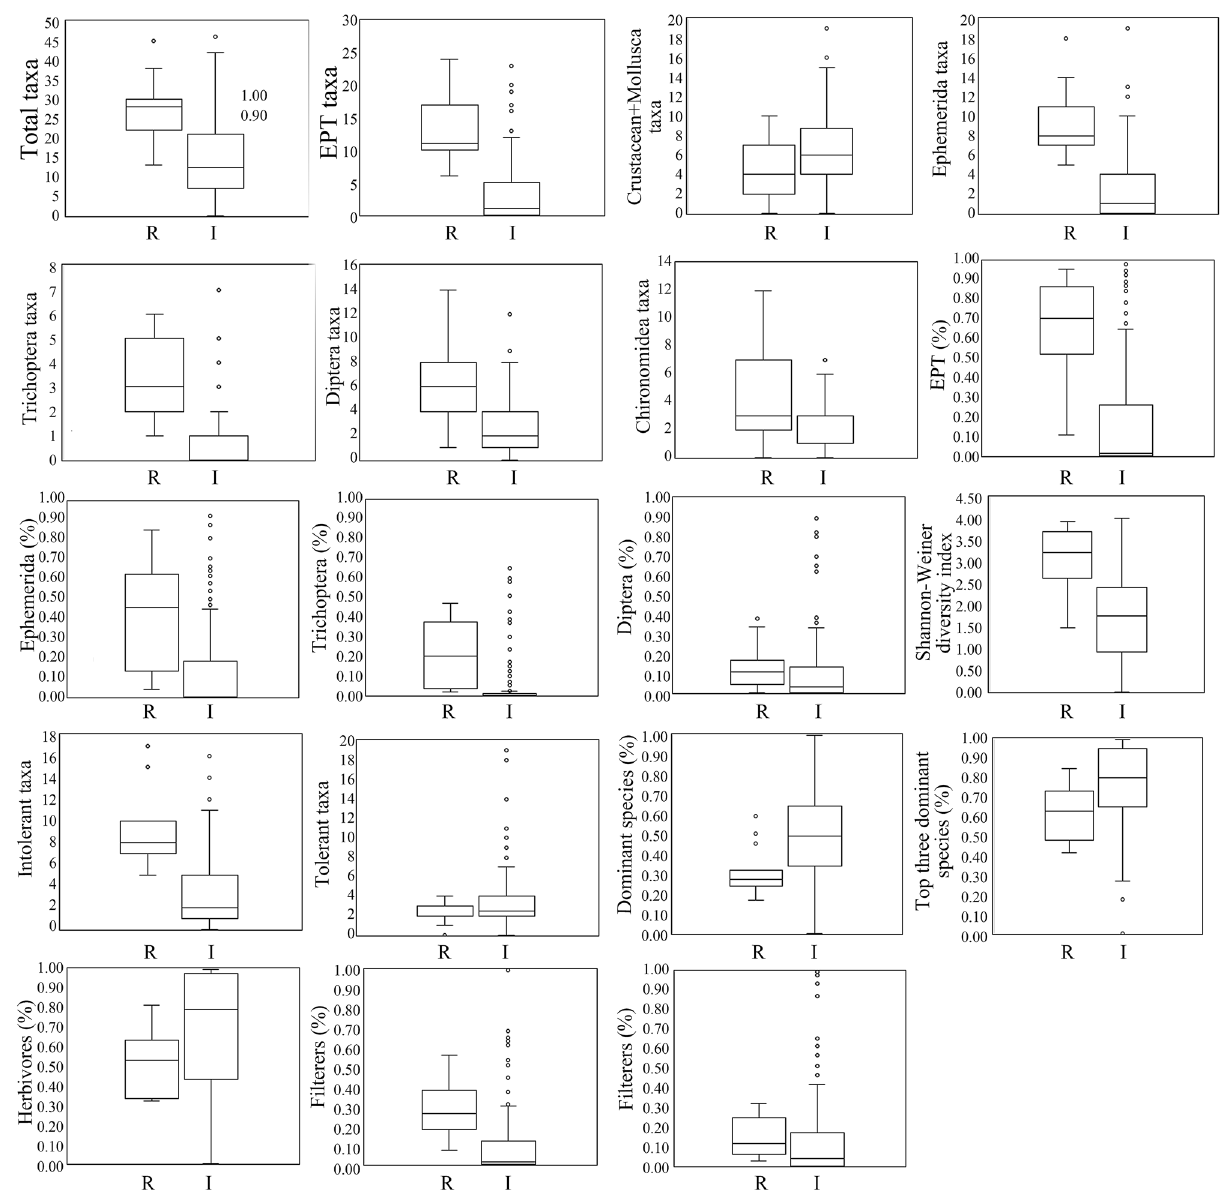
Figure 1. Box-plot of candidate metrics of reference sites and impaired sites. R reference sites, I impaired